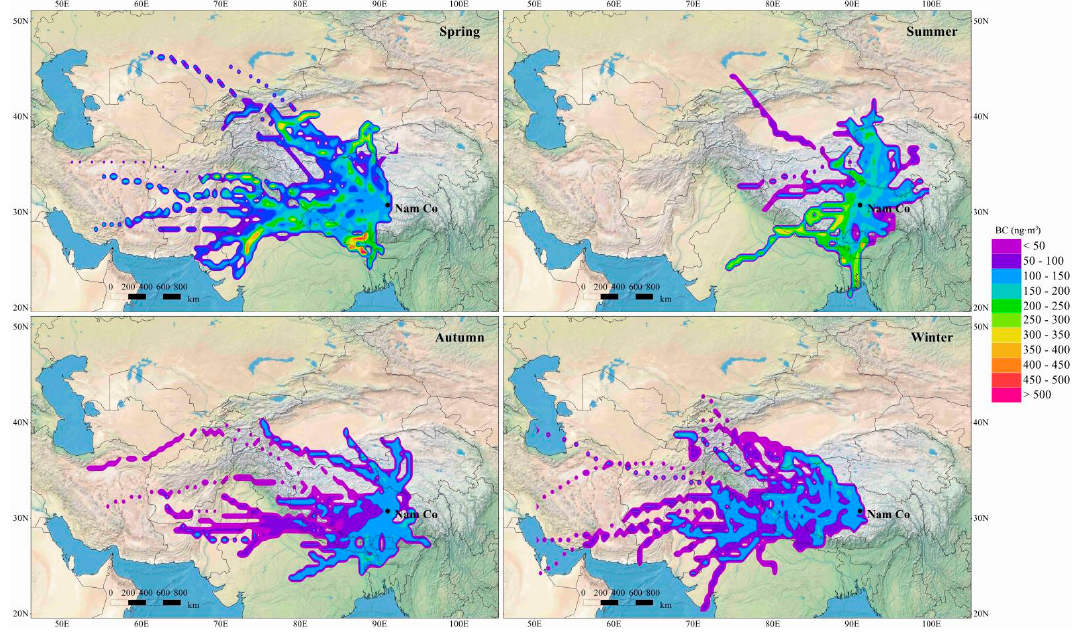
Figure 9. Seasonal distribution of concentration-weighted trajectory (CWT) of BC.